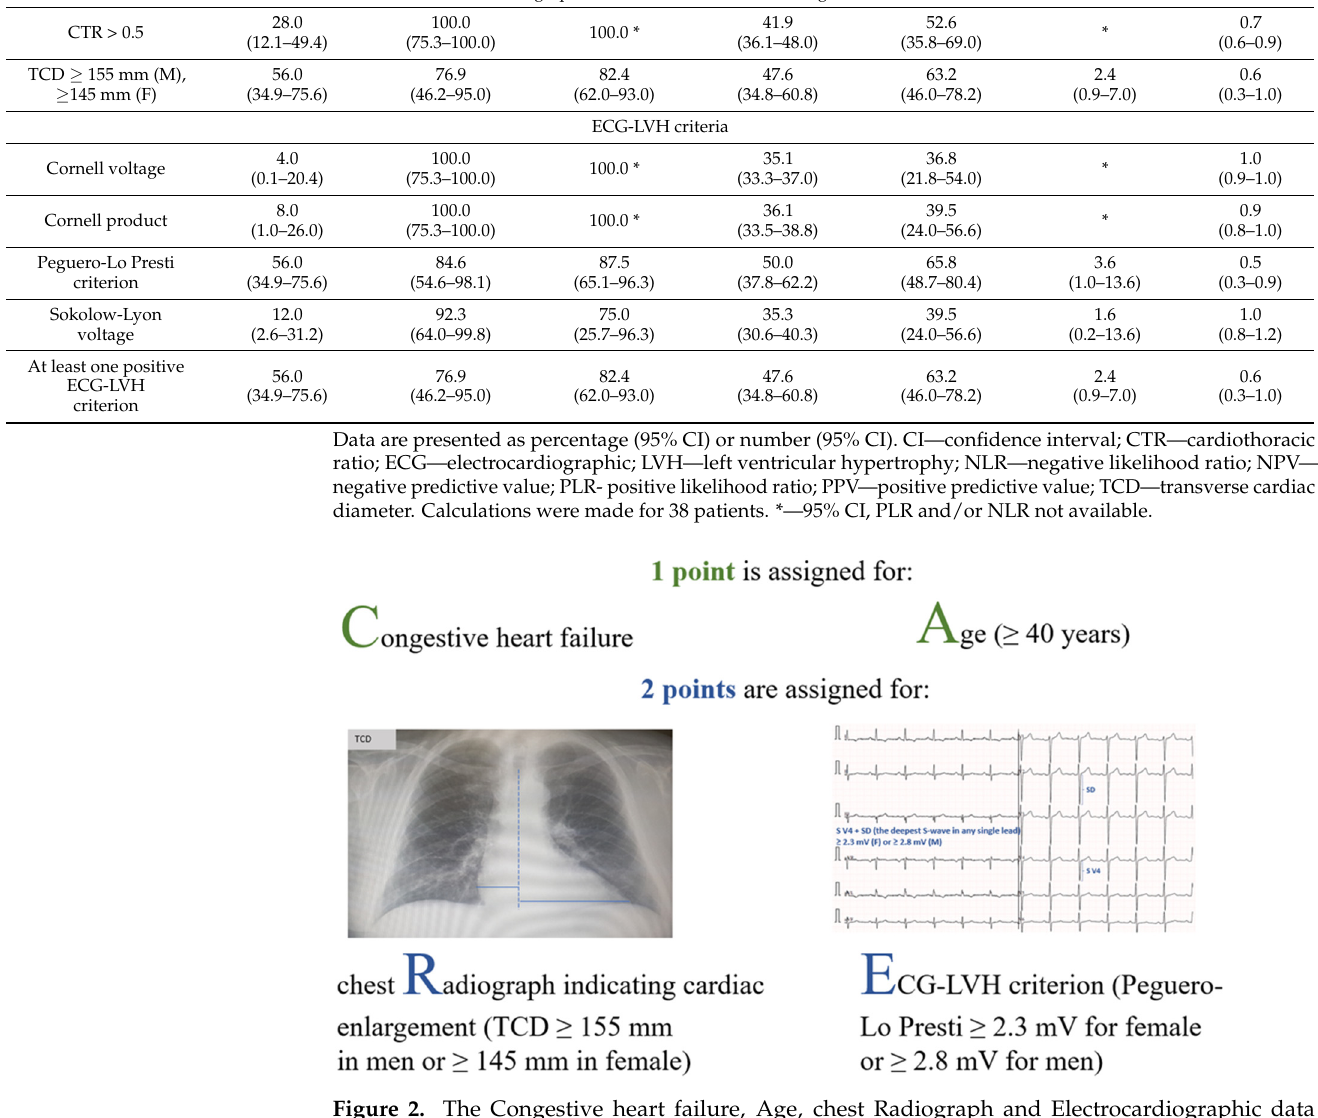
Table 5. Combined criteria in the screening of left ventricular hypertrophy in patients with and without left ventricular hypertrophy based on left ventricular mass indexed by body surface area. Parameters